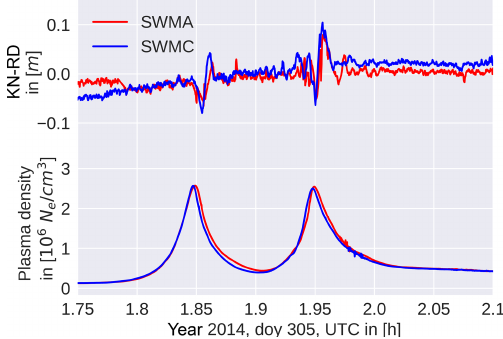
Figure 1. Orbit differences in the radial component between kine- matic positions (KN) and a reduced-dynamic (RD) orbit fit (top) and plasma density during an equatorial